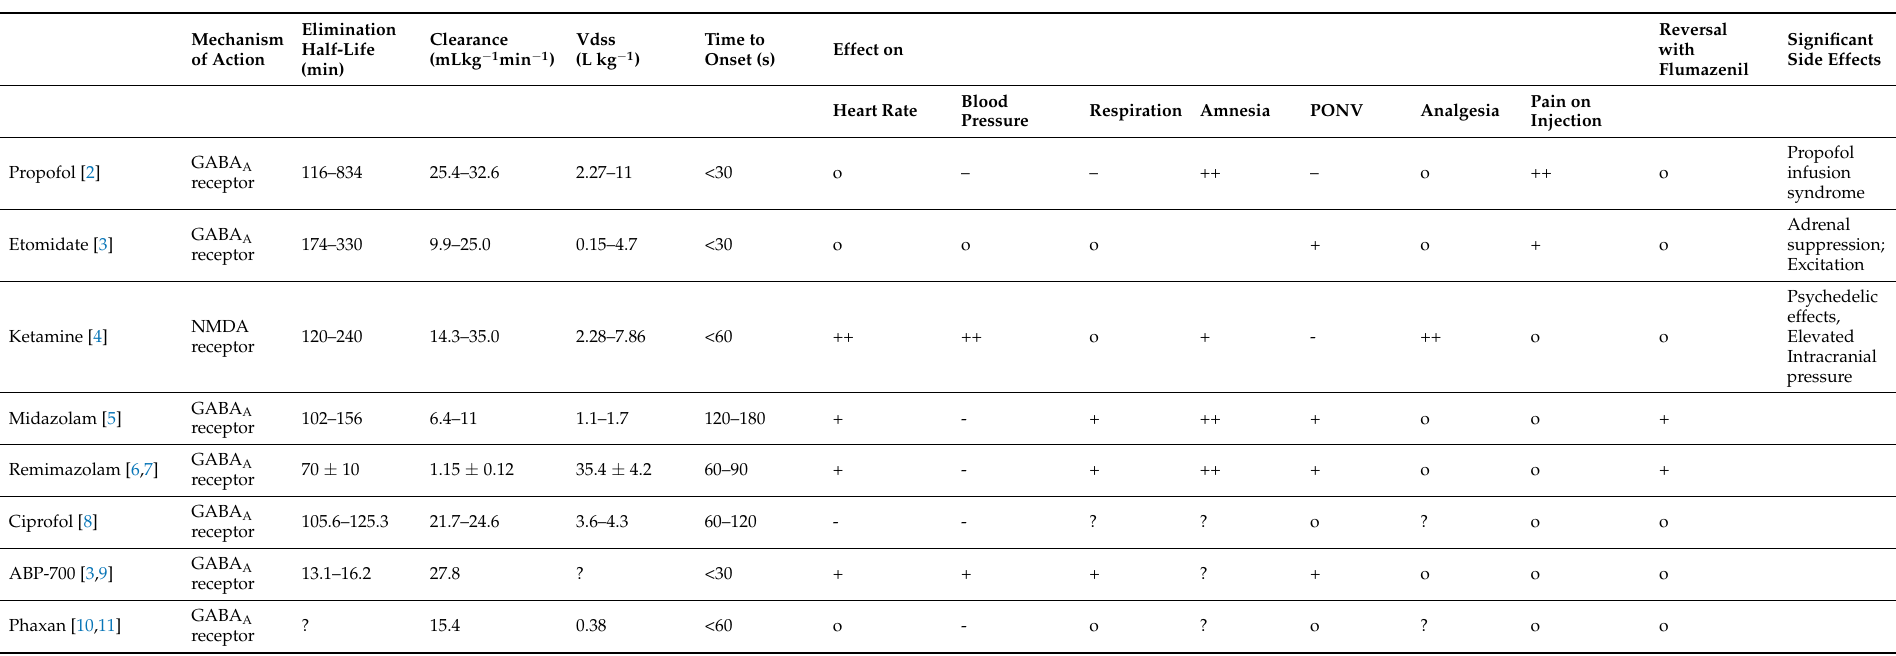
Table 1. Pharmacokinetic and pharmacodynamic parameters of established hypnotic agents and new hypnotic agents in the clinical phase of drug development. PONV = postoperative nausea and vomiting. Data after an established induction bolus dose. Values are represented as ranges or mean ± SD. o is no effect, – strong negative, - less negative, ++ strong positive, + positive, ? is